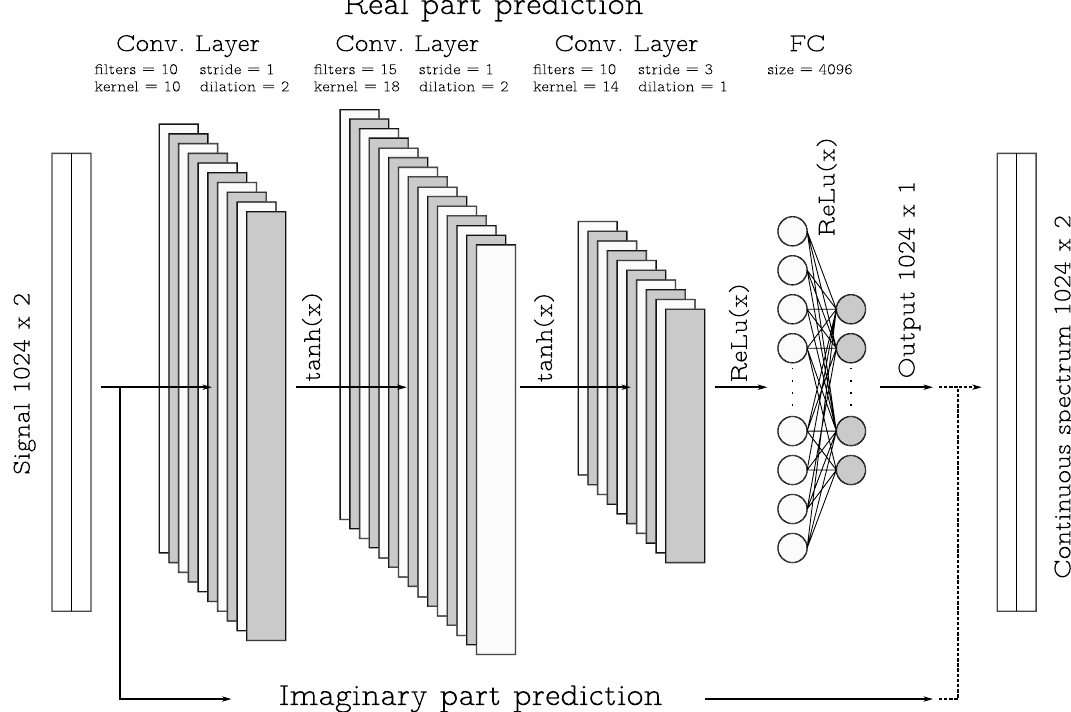
Figure 3. The schematic of NFT-Net topology: the extended scheme presents the sequence of operations for the processing of real part; the processing of imaginary part is identical (marked with the long arrow below the scheme). The numbers indicating the layers/arrays sizes refer to our processing 1024 complex-valued signal